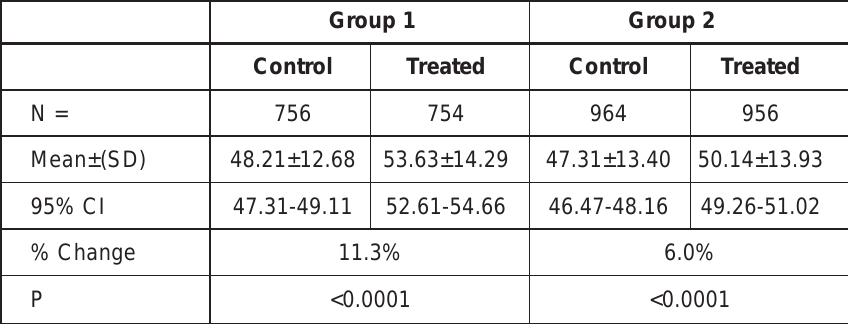
Table 1: Fibre diameter in µm, expressed as the mean and one standard deviation (SD), with the 95% confidence interval (CI) and percentage change in mean fibre diameter between the control limb and treated limbs in Groups 1 and